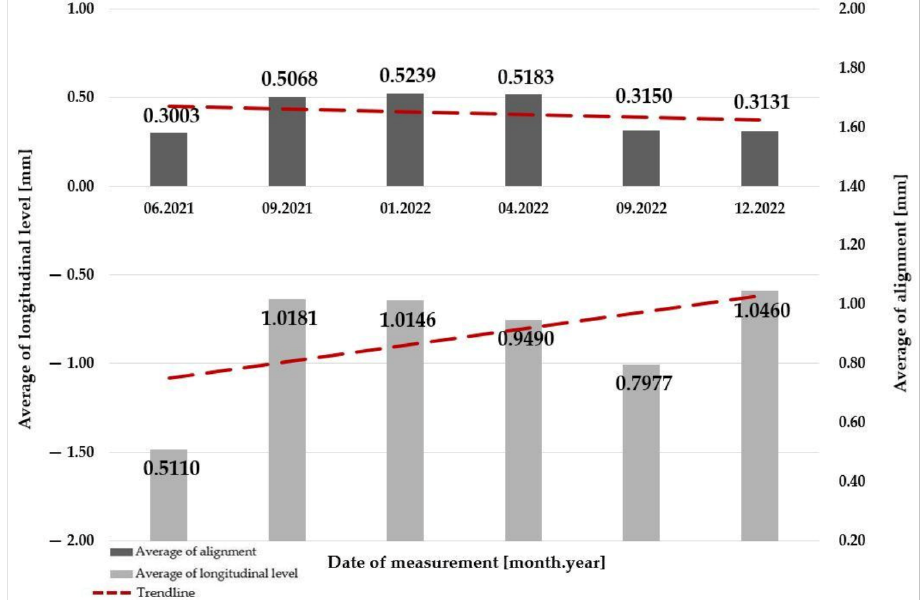
Figure 19. The change of average values of longitudinal level and alignment in Section